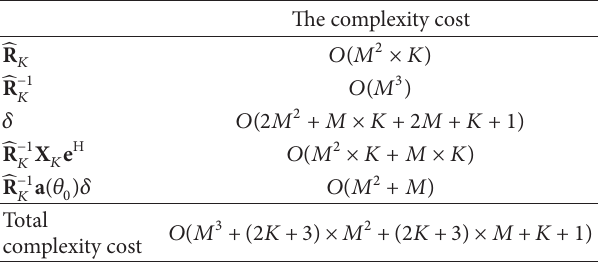
Table 1: The complexity cost of the conventional LSCMA.